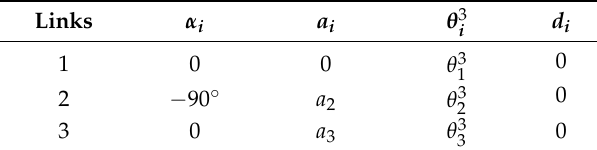
Table 6. DH parameters of the 3 ‐ DOF upper ‐ limb exoskeleton.